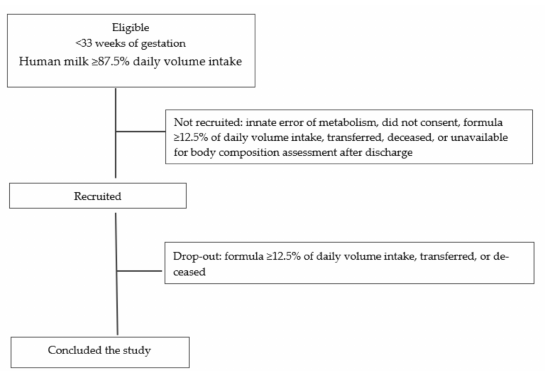
Figure 1. Flow diagram including the eligibility, recruitment, and drop-out criteria, used in both study arms: standard and target human milk